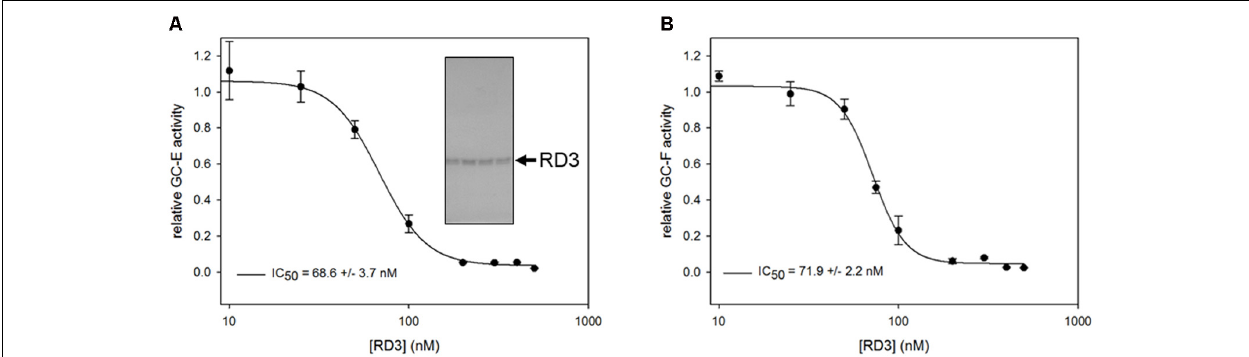
FIGURE 1 | Inhibition of GC-E (A) and GC-F (B) wild-type expressed in HEK-293T cells by purified RD3. GC-E (left panel) and GC-F (right panel) were incubated with GTP containing buffer at 20 nM Ca 2 + , 5 µ M GCAP1 and increasing concentrations of RD3 (0–500 nM). Each incubation with RD3 was measured in triplicates. Data are shown as mean ± SD, curve fitting was performed with SigmaPlot 13 using a normal Hill equation. GC activities were determined by the level of produced cGMP analyzed by HPLC. Inset: Coomassie stained SDS-gel with fractions containing purified RD3.